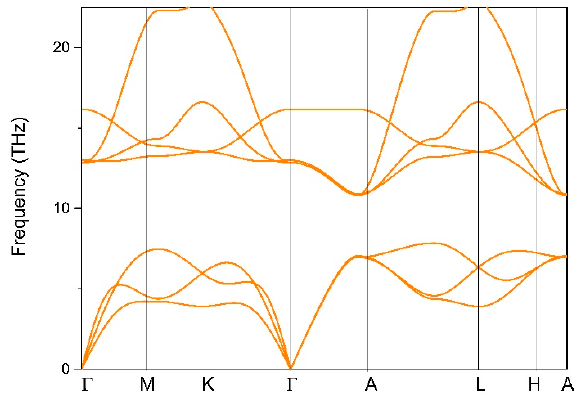
Figure 2. Phonon dispersion curve for CrB 2 .